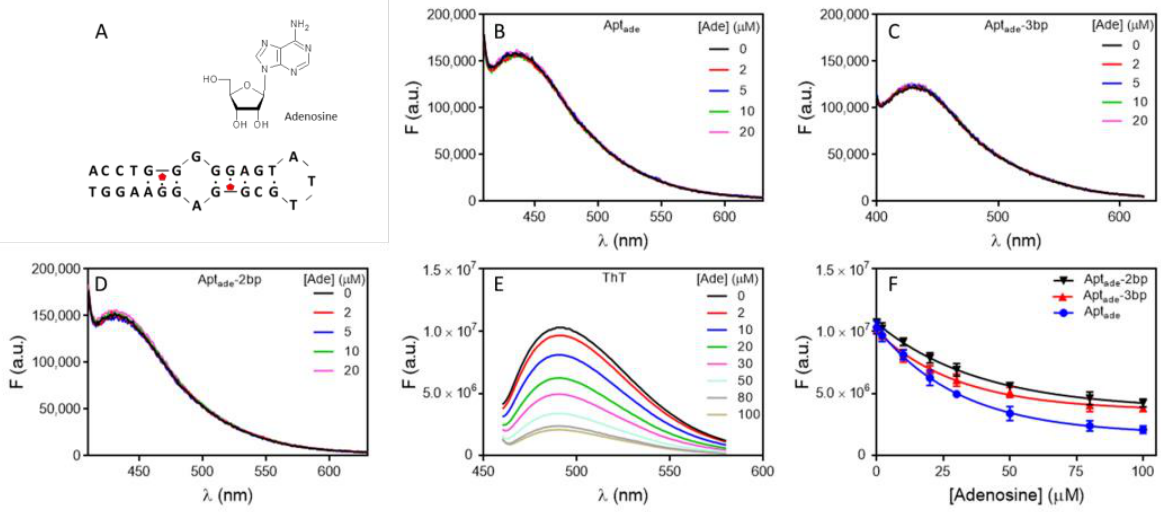
Figure 4. ( A ) The structures of the aptamer and adenosine. The fluorescence spectra of the ( B ) 4 bp ( C ) 3 bp and ( D ) 2bp adenosine binding aptamer upon titration of adenosine with 350 nm excita- tion. ( E ) The fluorescence emission spectra of ThT staining 100 nM of the adenosine aptamer after adding different concentration of adenosine in buffer (10 mM PB, 100 mM NaCl, 10 mM MgCl 2 pH 7) with 450 nm excitation. ( F ) The fitted binding curves based on ThT staining of the three ap- tamers.